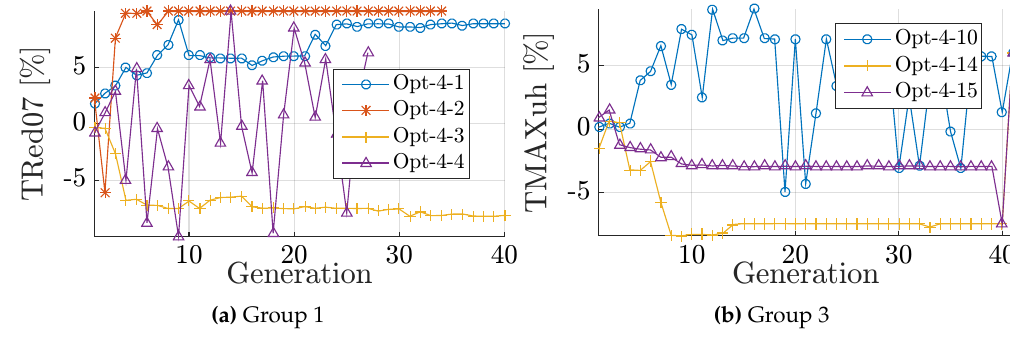
Figure 12. Development of blade thickness parameter at r / R = 0.7 as median per generation, relative to baseline design. ( a ) Group 1; ( b ) Group